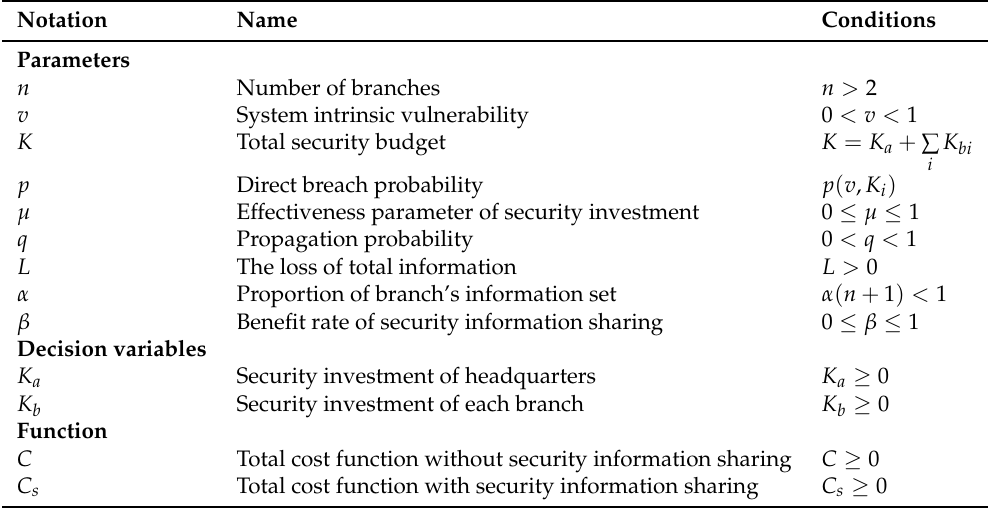
Table 1. Summary of notations.